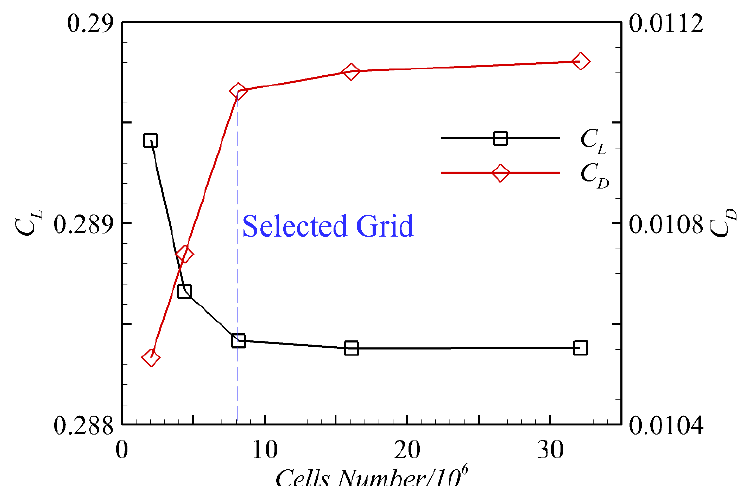
Figure 5. Grid convergence study at Ma = 0.2, α = 6°.